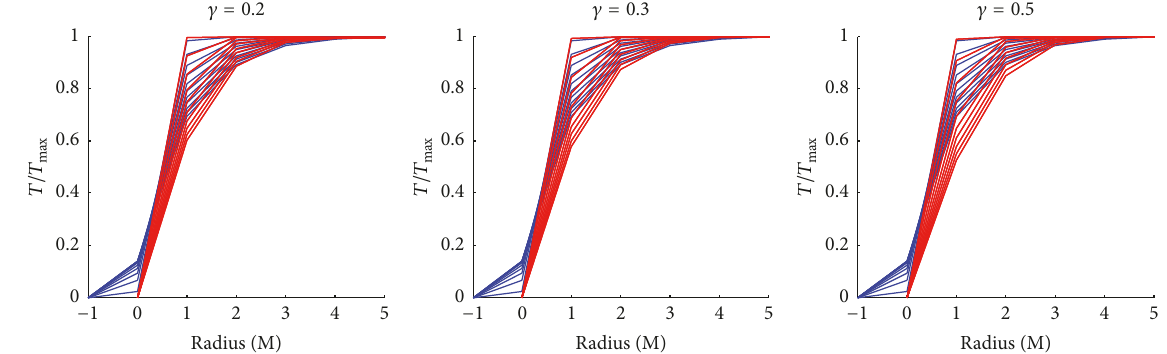
Figure 9: MWX ambient crustal section fluid flow heat advection spatiotemporal profiles for three values of Peclet number 𝑃 𝑒 = 2 𝛾 = 𝑎 0 𝜑 V 0 /𝐷 . Blue curves are numerical model temperature fields; red curves are analytic temperature fields (16). Panels are titled by effective Peclet number 𝑃 𝛾 determined by analytic wellbore-centric advective flow temperature field for a sequence of model evolution times. Away from the 𝑒 = 2 high porosity sections of the wellbore where fluid flows into the wellbore, the effective Peclet number 𝑃 𝑒 ∼ 0.5 implies advective heat flow on the order of thermal conduction heat flow. The analytic curves are reasonable fits to the numerical curves because the model fluid inflow is more or less uniform along the wellbore axis as assumed for the analytic expression.